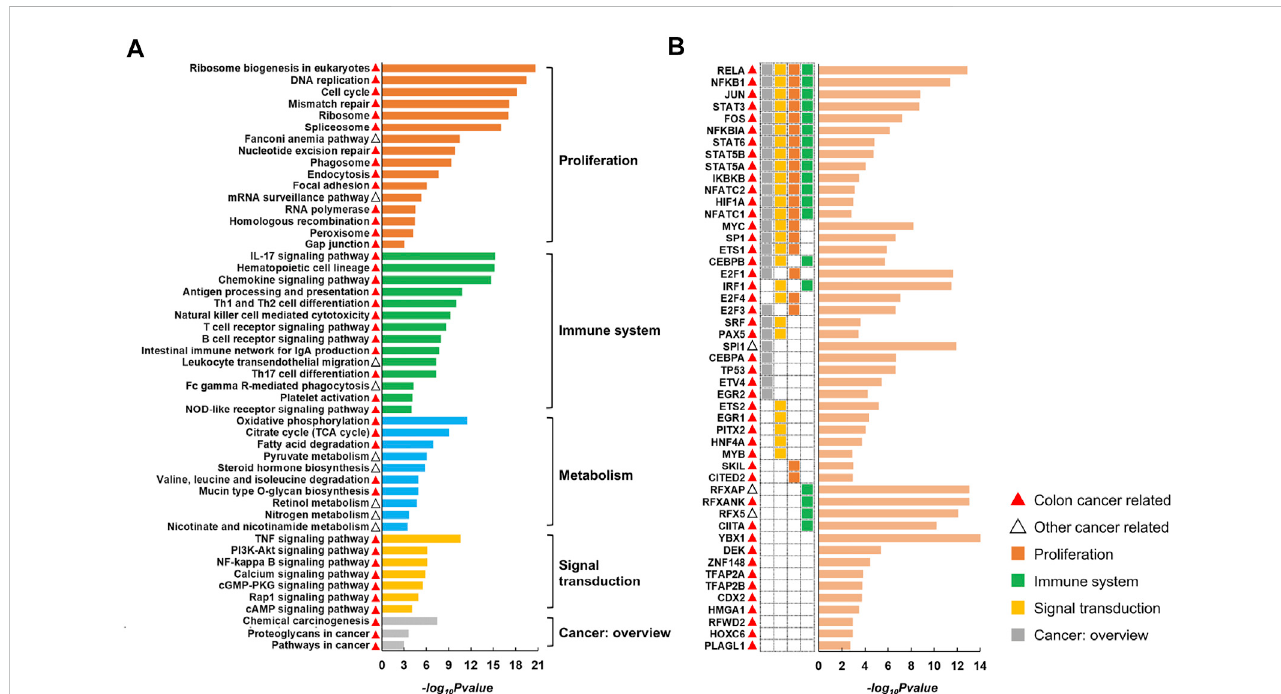
FIGURE 3 Representative pathways (A) and TFs (B) identi fi edby enrichmentanalysisof CRC modules. The histogram displaysthenegativelog10of theenrichment p -values. The red and black triangles indicate that the corresponding entry has been reported to be associated with colon cancer or other cancer types. The pathways can be divided into fi ve classes according to KEGG